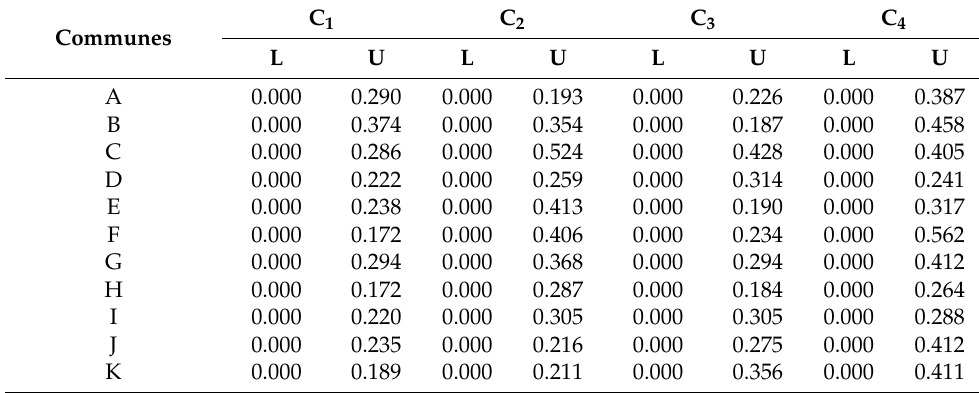
Table 9. Degrees of hesitancy in the form of intervals for criteria C 1 –C 4 .